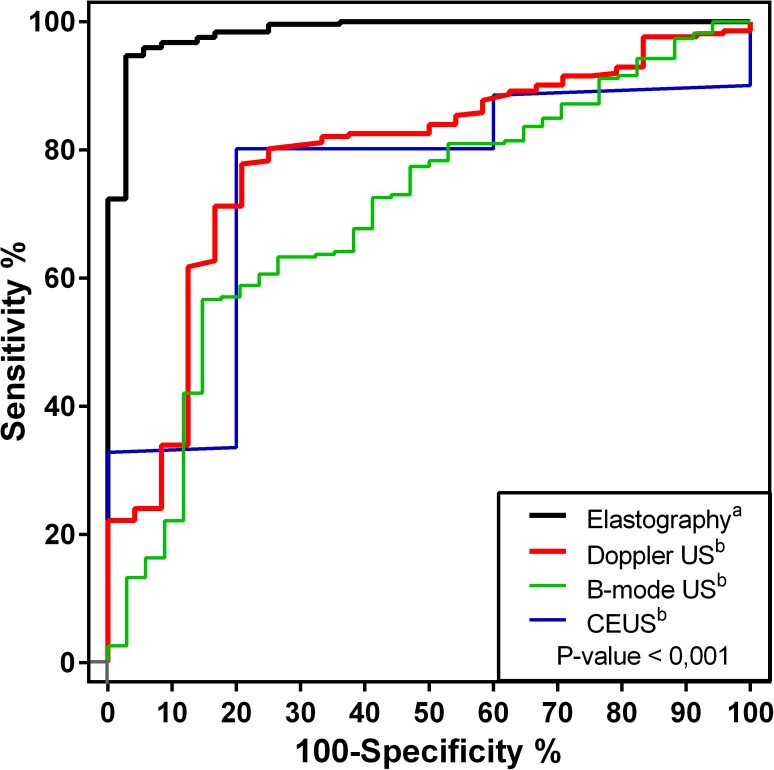
Receiver-operating characteristic curve comparing predictive sensitivity (%) and specificity (100-%) of different ultrasonography methods in determining malignancy in canine mammary masses using histopathological classification as a reference.Different letters indicate significant difference.